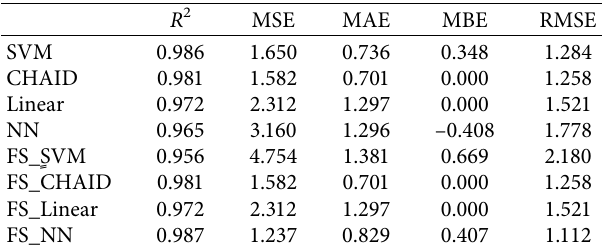
Figure 5: Overall error relationship (training and testing data sets) between the real and predicted values with and without feature selection Table 6: Results of training data set with and without feature selection model.